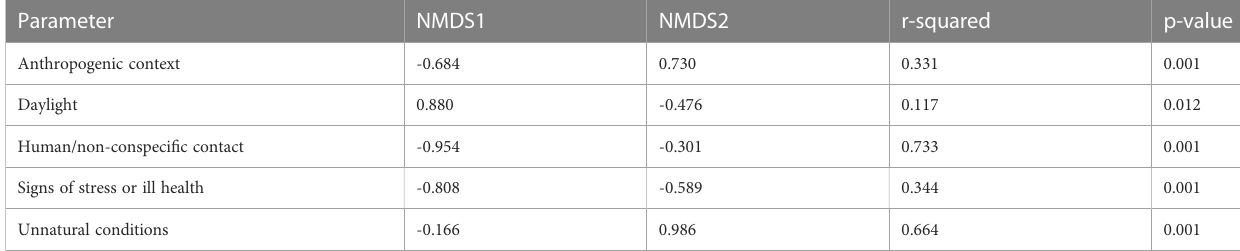
TABLE 3 First and second axes of the Non-Metric Dimensional Scaling and relative importance of each parameter.